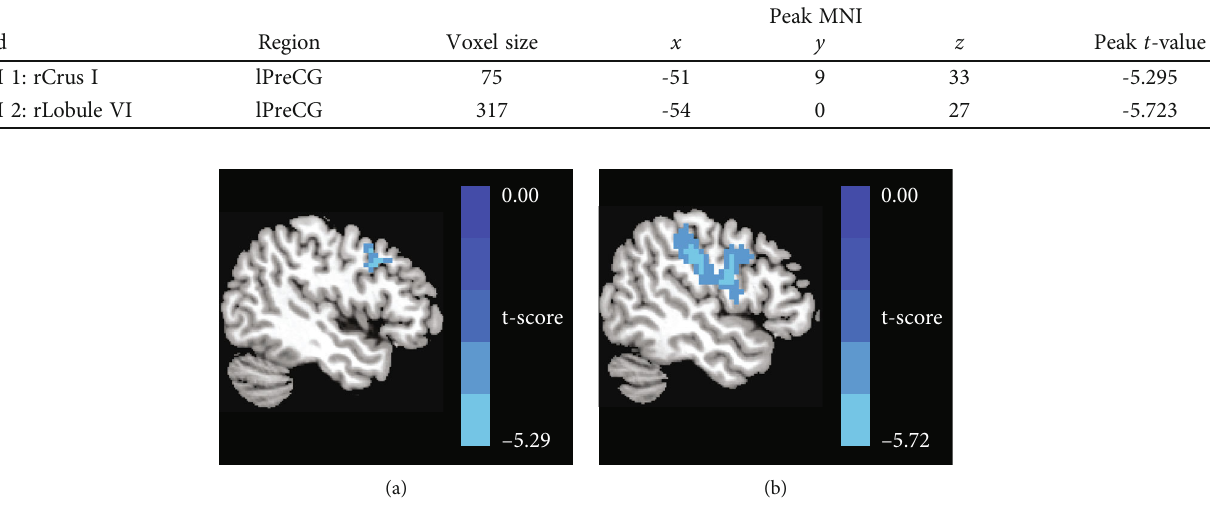
Figure 5: With the use of ROI 1 and ROI 2 as the seed in seed-based FC analysis separately, the result showed decreased FC (a) between the rCrus I and the lPreCG, as well as (b) between the rLobule VI and the lPreCG.